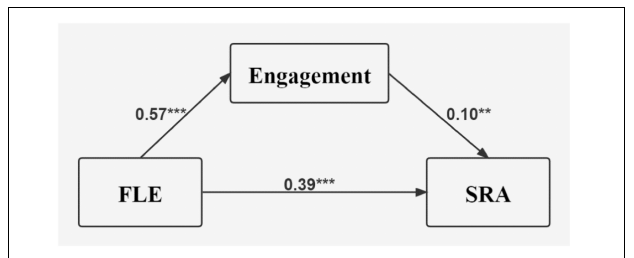
FIGURE 1 | The mediation model 1. All are standardized coefficients, ** p < 0.01, *** p < 0.001, FLE, foreign language enjoyment; SRA, self-reported achievement.